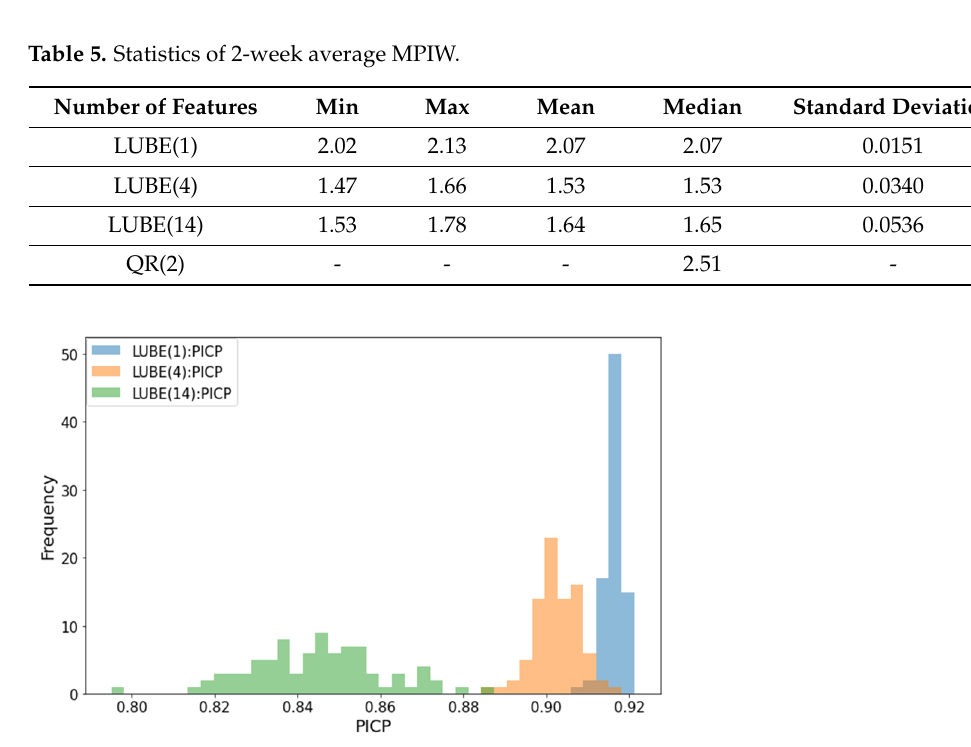
Figure 9. Histograms of 2-week average PICP for LUBE (1), (4), and (14).